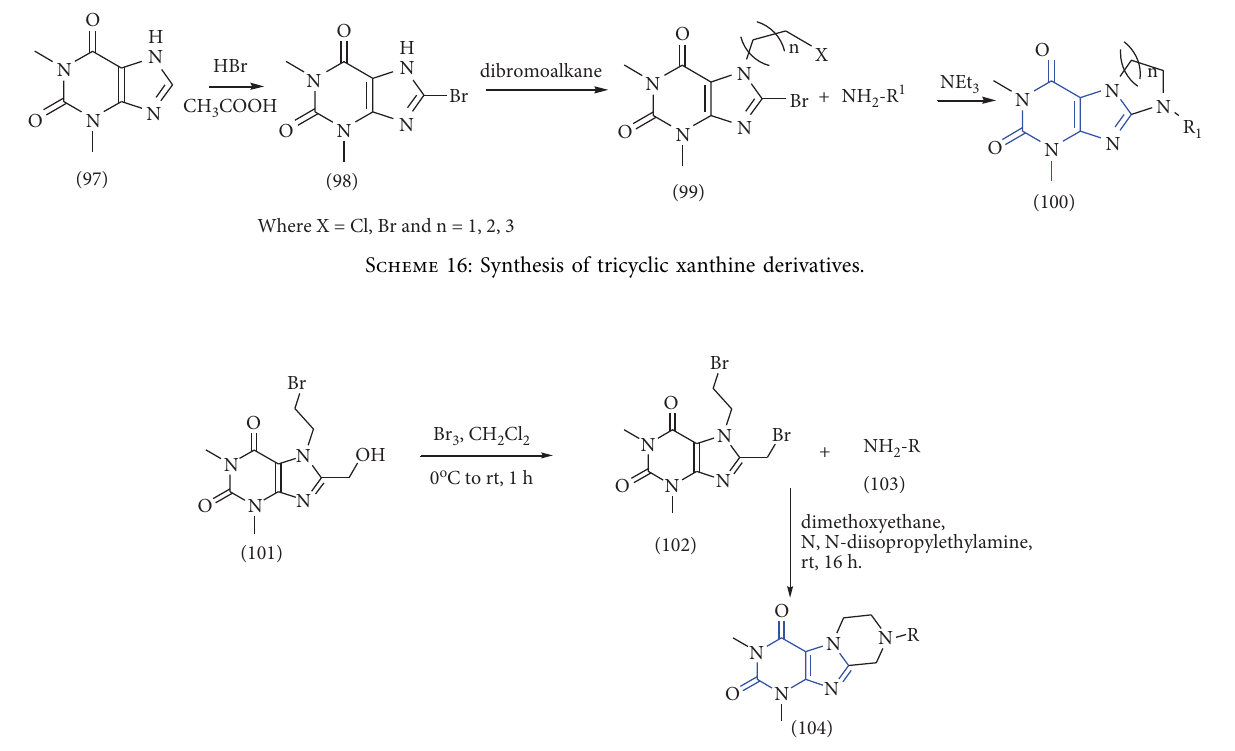
Scheme 17: Synthesis of N8-substituted 1,3-dimethyltetrahydropyrazino [2,1-f]